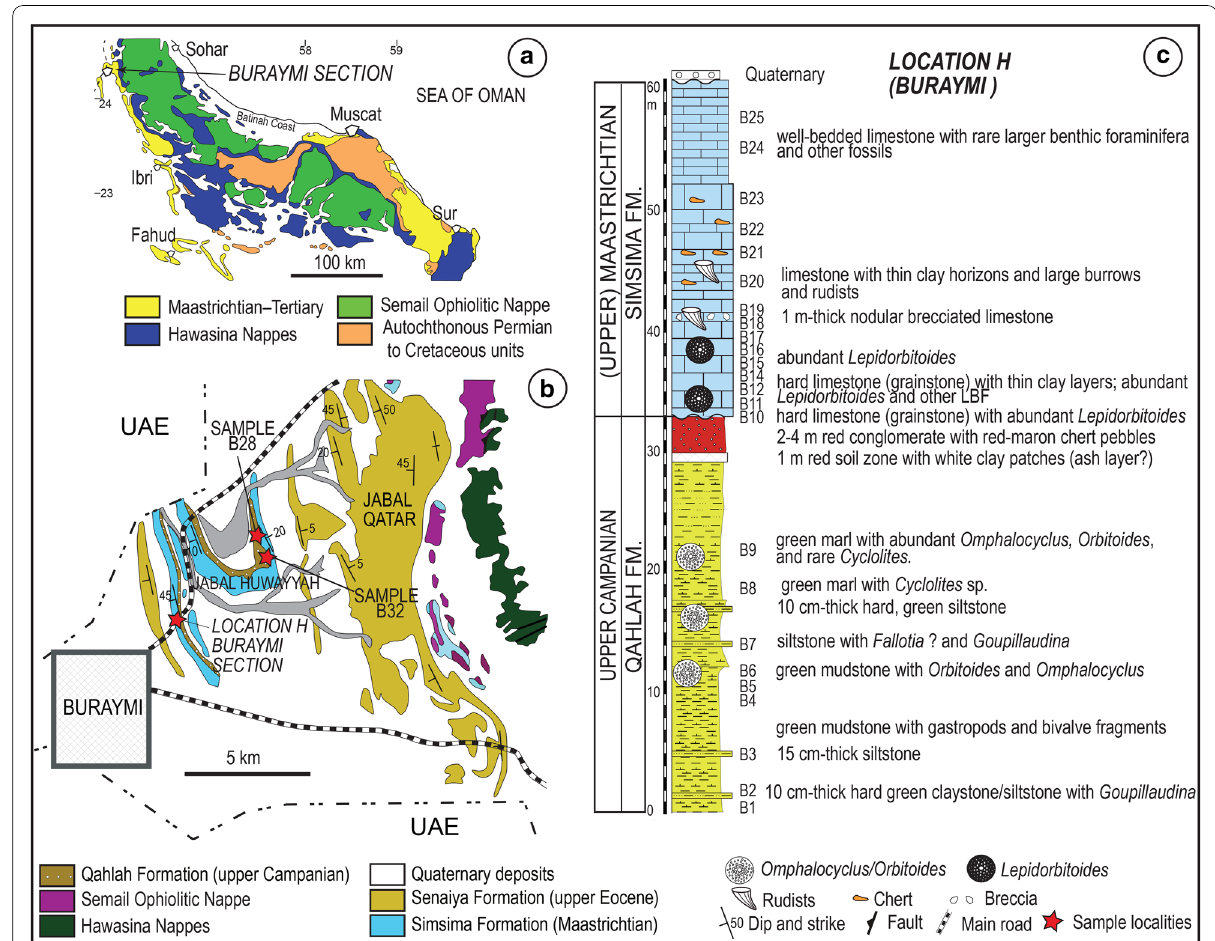
Fig. 5 a Simplified geological map of the Oman Mountains (after Glennie et al., 1974). b Geological map of the Buraymi region and location of the Buraymi Section and samples 28 and 32 (map simplified from Métour et al. 1992). c Lithostratigraphic columnar section of the Qahlah and the Simsima